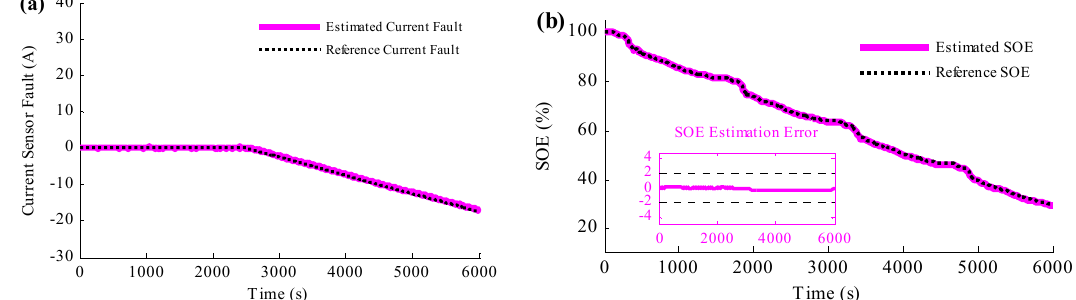
Figure 9. Simulation results when the current sensor fault is ramp-type and the method to simultaneously detect the current sensor fault and estimate the SOE is applied: ( a ) the estimated current fault results; ( b ) the SOE estimation results.